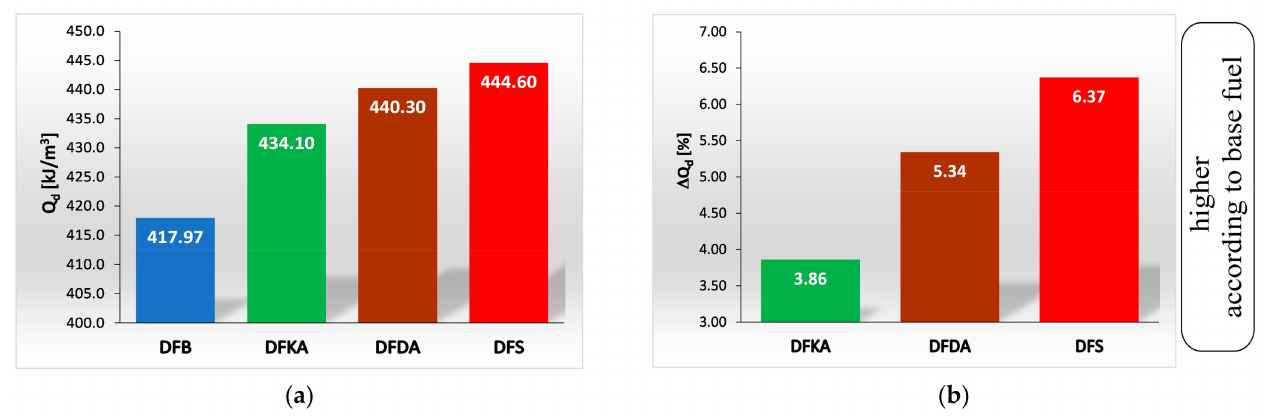
Figure 26. ( a ) Heat of diffusion phase (Q d ) for tested fuels. ( b ) Percent change in heat of diffusion phase ( ∆ Q d ) for tested fuels relative to Q d for DFB (base